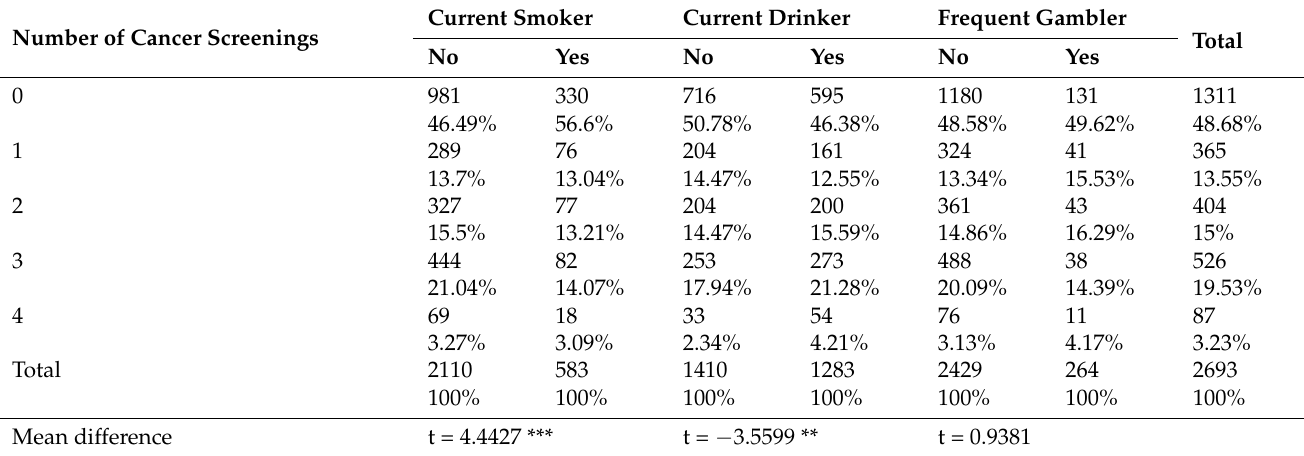
Table 5. Distribution of the number of cancer screenings by risky health